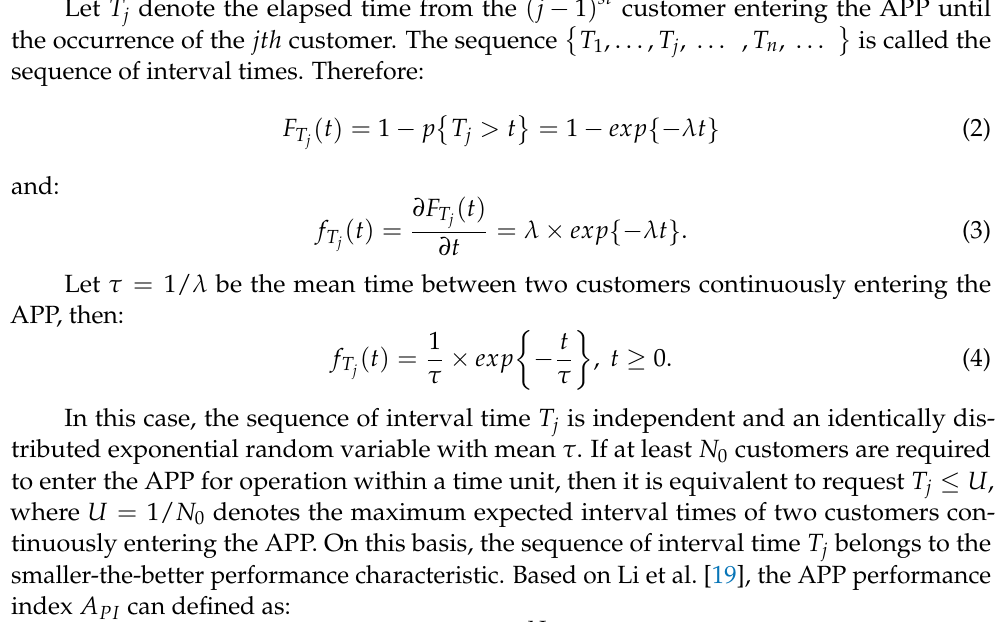
Figure 1. Various values of performance index